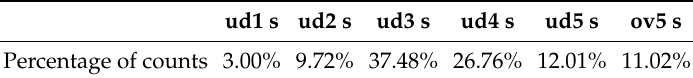
Table 2. Acceptance button click time count per second.